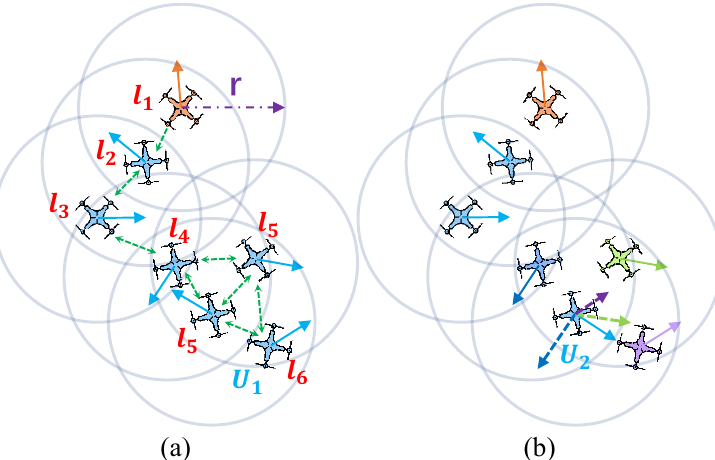
Figure 2. Relationships between UAVs. ( a ) Definition of different layers of UAVs and interaction topology diagram between UAVs. ( b ) Vector synthesis of UAV velocity. The individual U 1 be- longs to the 6-th layer instead of the 7-th layer because the length of the shortest neighborhood sequence is 5. In ( a ), the direction of the green dashed arrow represents the movement information flow direction. ( b ) shows the synthesis process of the movement direction of the individual U 2 . The dotted line represents the influence of other individuals on U 2 and the length represents the contribution